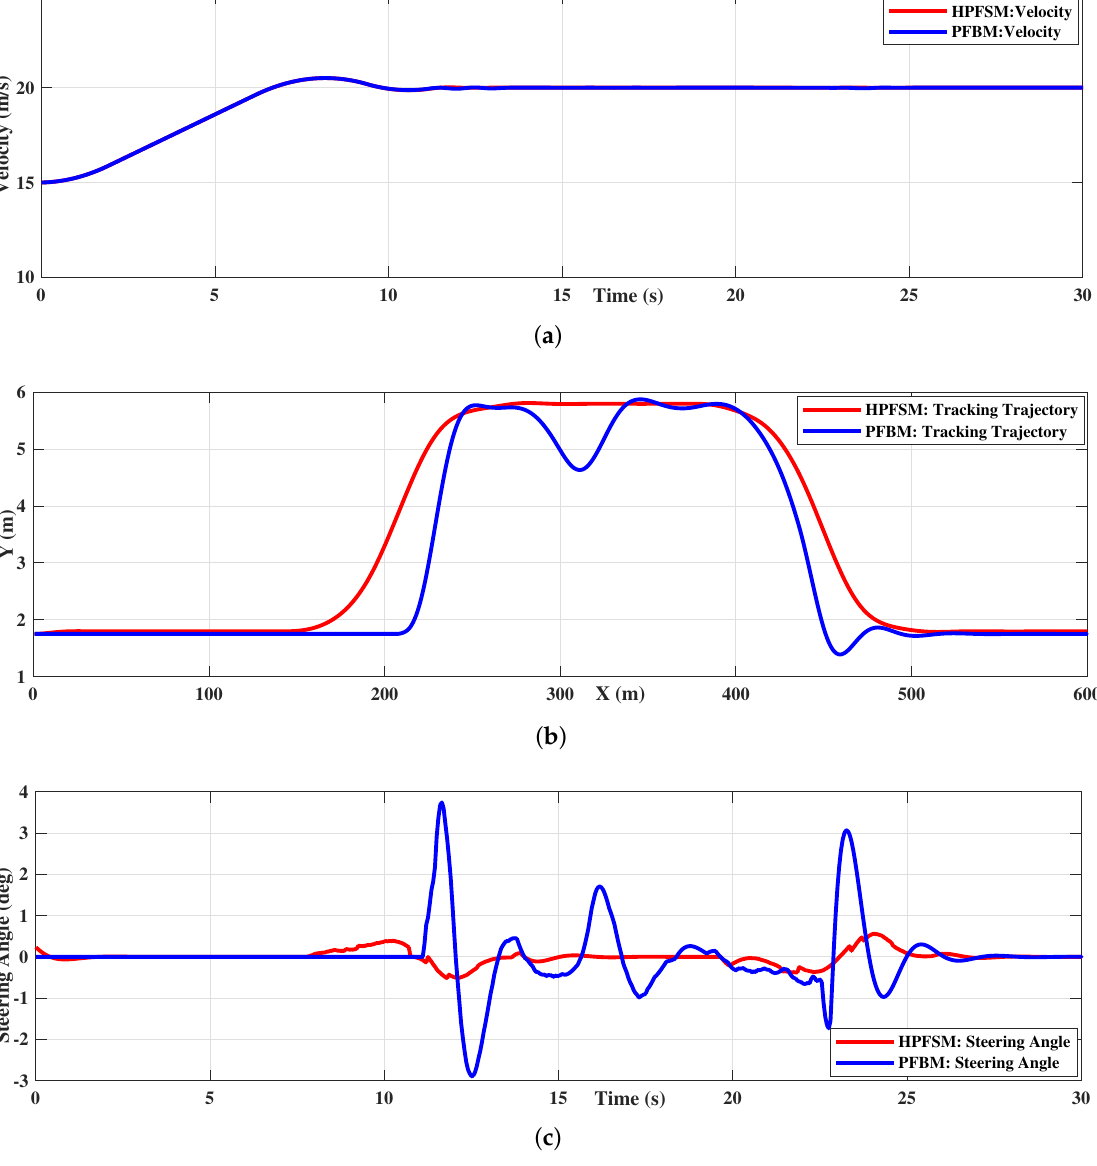
Figure 16. An overtaking scenario with multivehicle distributed in short interval distance: ( a ) HPFSM vs. PFBM: Tracking velocity; ( b ) HPFSM vs. PFBM: Tracking trajectory; ( c ) HPFSM vs. PFBM: Steering angle of front